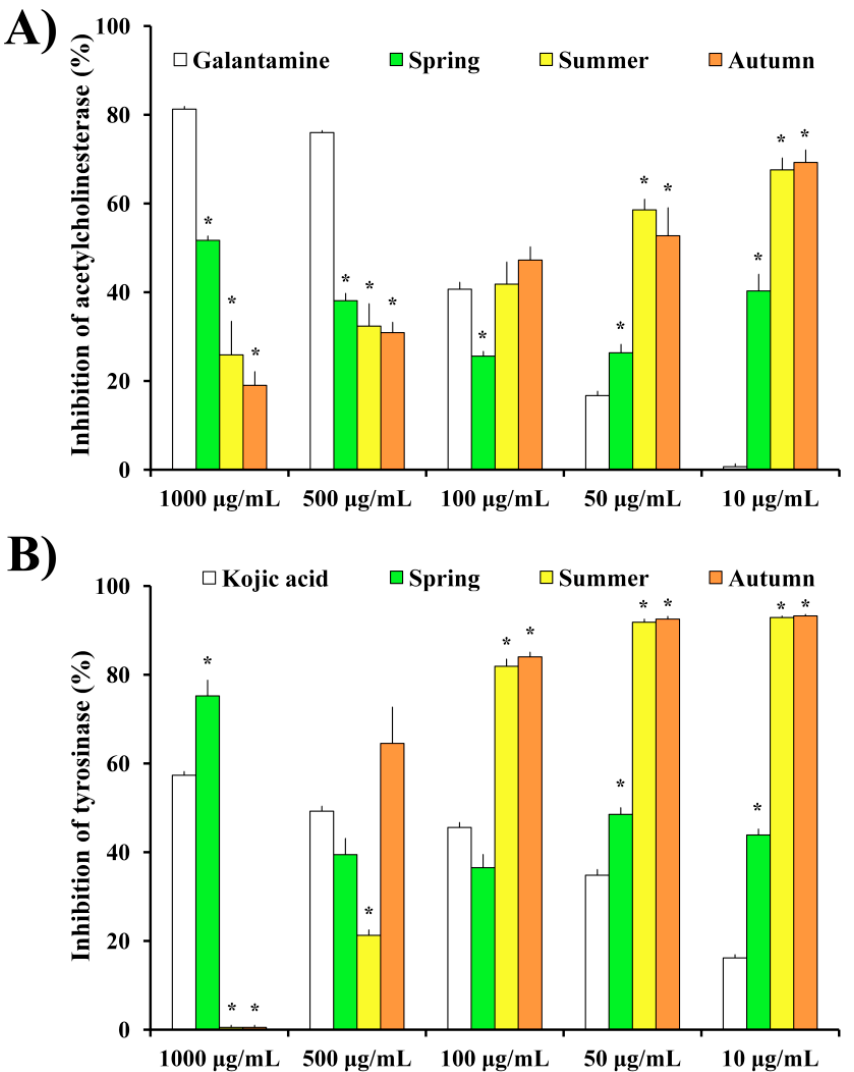
Figure 5. The inhibitory potential of H. cupressiforme ethyl acetate extracts from different seasonal aspects (spring, summer, and autumn) on ( A ) AChE and ( B ) mTyr. The results are expressed as the mean ± standard error (* p < 0.05 different seasonal aspects vs. corresponding standard substances).